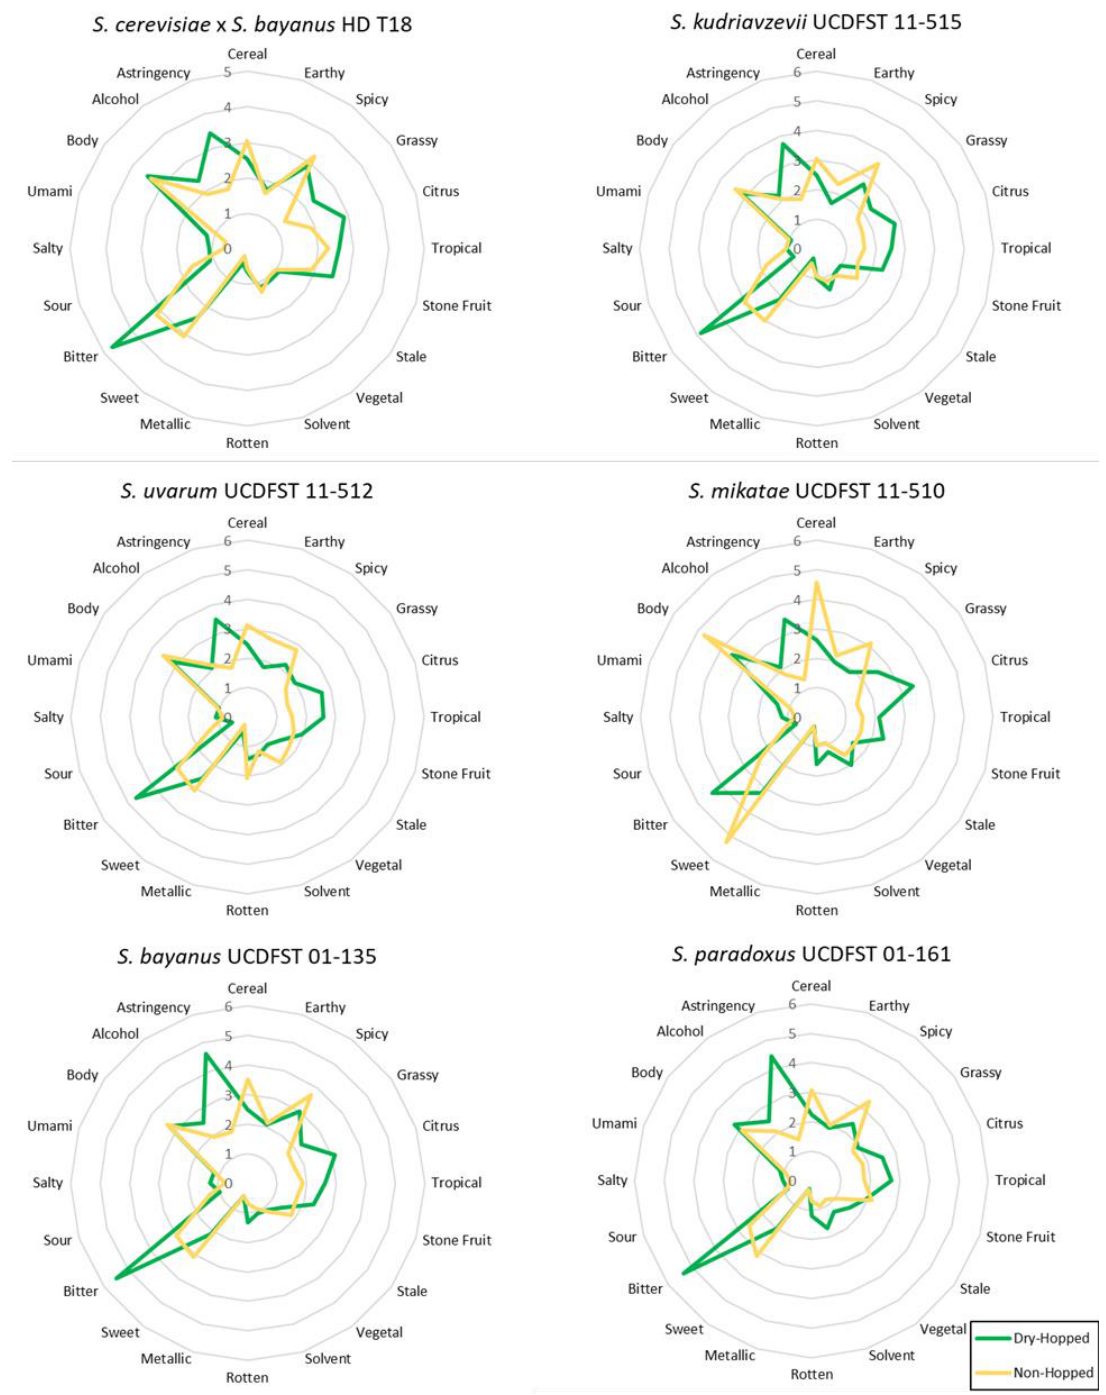
Figure 4. Radar charts of attributes for each experimental yeast fermentation in this study. Dry-hopped treatments are shown in green, while non-hopped are shown in yellow. ( n = 51, with 36 male and 15 female). Other descriptors were written in on the ballot (Table 2) by the trained panelists at